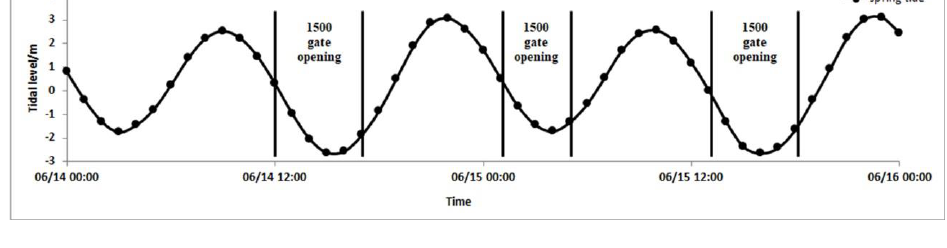
Figure 5. Transmission (TM) model calibration: comparison between model simulated and measured values of each index in Haimen station. ( a ) Salinity; ( b ) DIN; ( c ) o-phosphate.